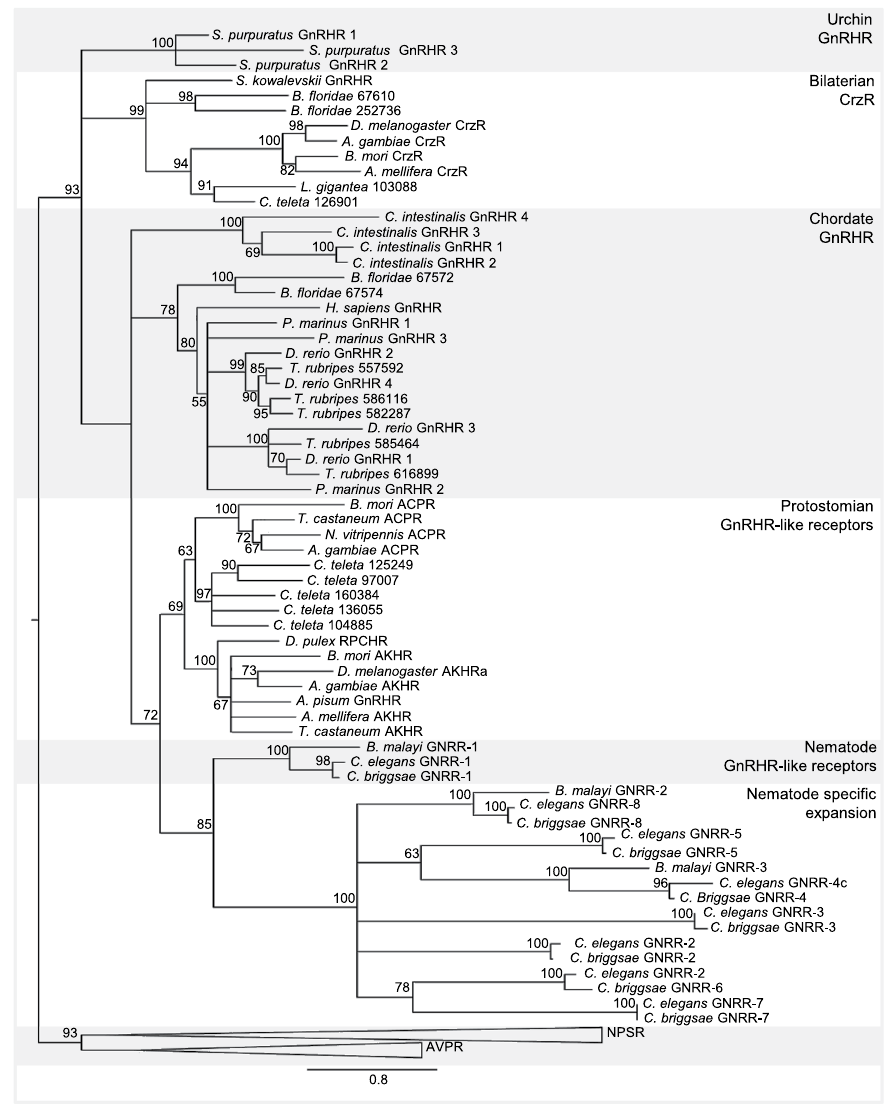
Figure 1. Maximum likelihood tree of vertebrate and invertebrate GnRH/AKH receptors. Branch lengths indicate the expected number of substitutions per site. Node numbers are branch support values (%) derived from 100 non-parametric bootstraps. Accession numbers are provided in Materials and Methods. ACPR, adipokinetic hormone/corazonin related peptide receptor; AKHR, adipokinetic hormone receptor; AVPR, arginine vasopressin receptor; CrzR, corazonin receptor; GnRHR, gonadotropin-releasing hormone receptor; GNRR, gonadotropin-releasing hormone receptor related receptor; RPCHR, red-pigment concentrating hormone receptor; NPSR, neuropeptide S